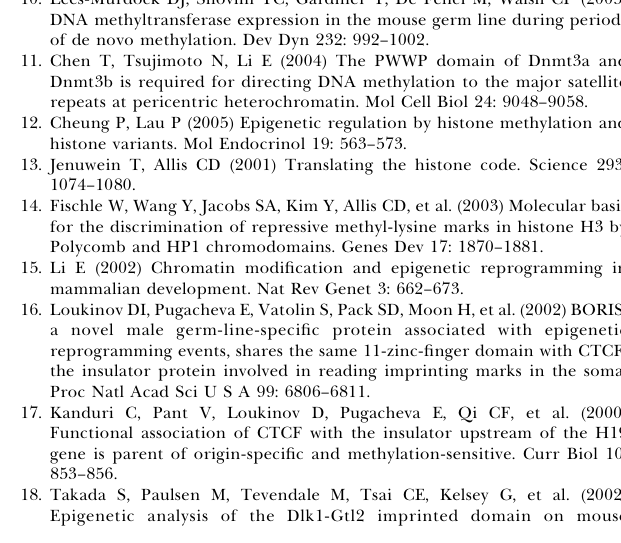
Figure S1. Western Blot Analysis of Dnmt3a and Dnmt3b Expressed in Nuclear-Injected Xenopus